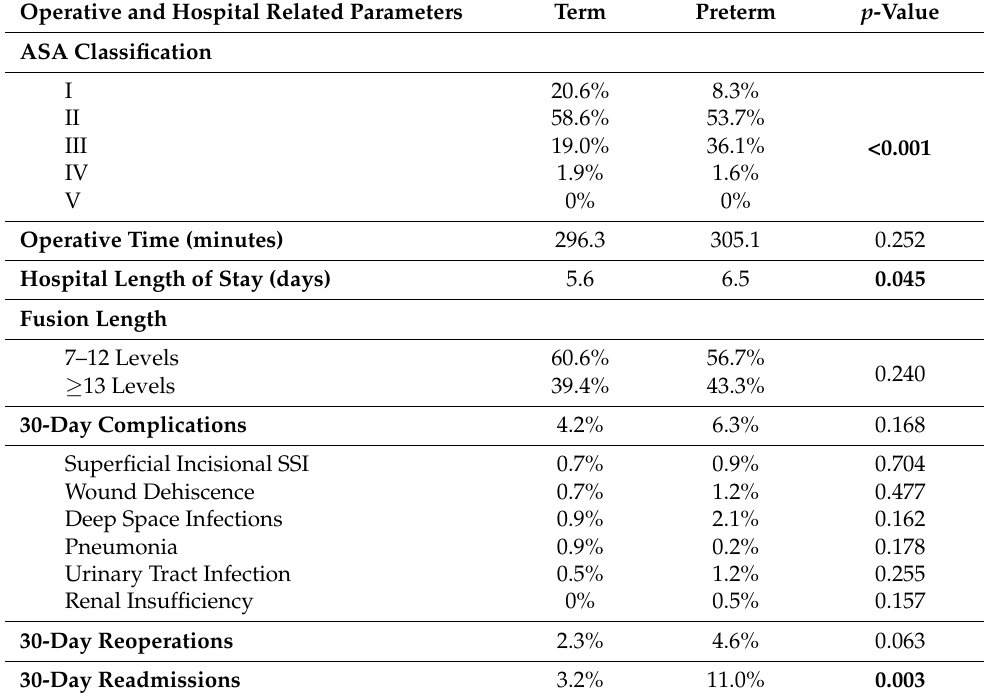
Table 3. Baseline comorbidities, hospital parameters, and outcomes across term ( ≥ 37 weeks), and preterm (includes MLP, VP, and EP) patients. Bold values are statistically significant ( p < 0.05). Operative and Hospital Related Parameters Term Preterm p -Value ASA Classification I 20.6% 8.3%